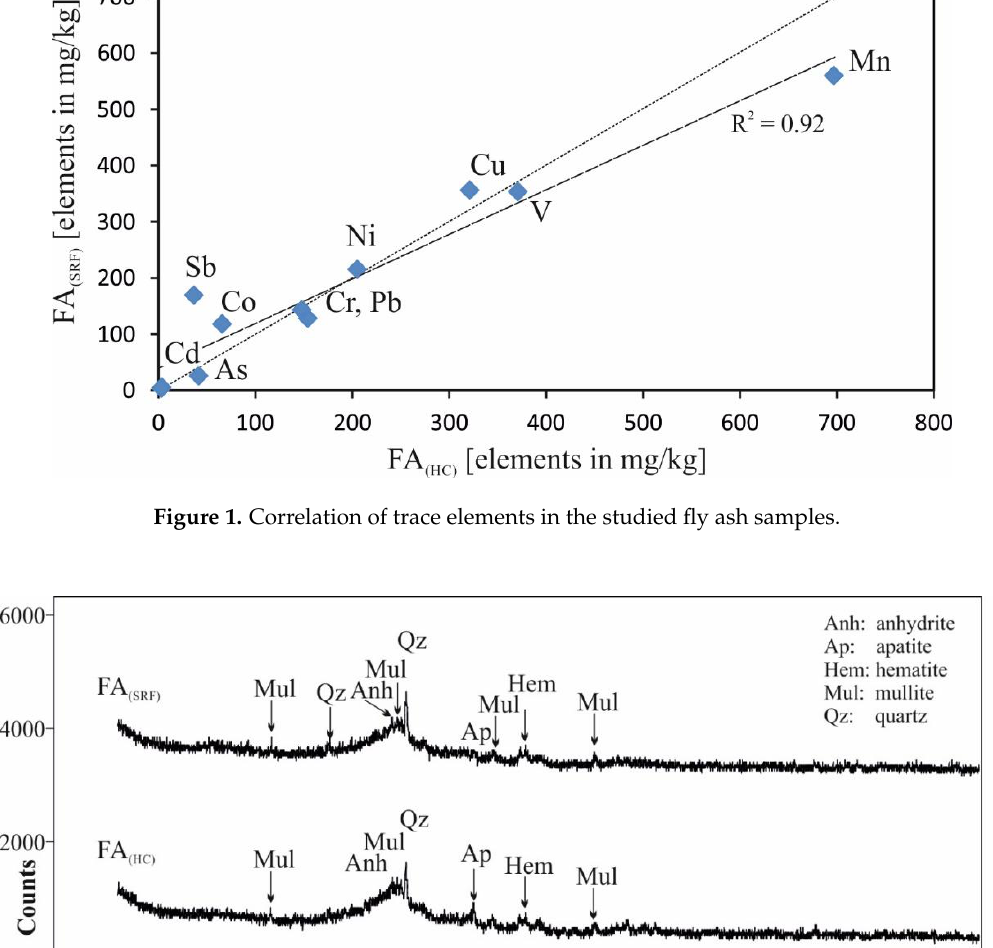
Figure 1. Correlation of trace elements in the studied fly ash samples.